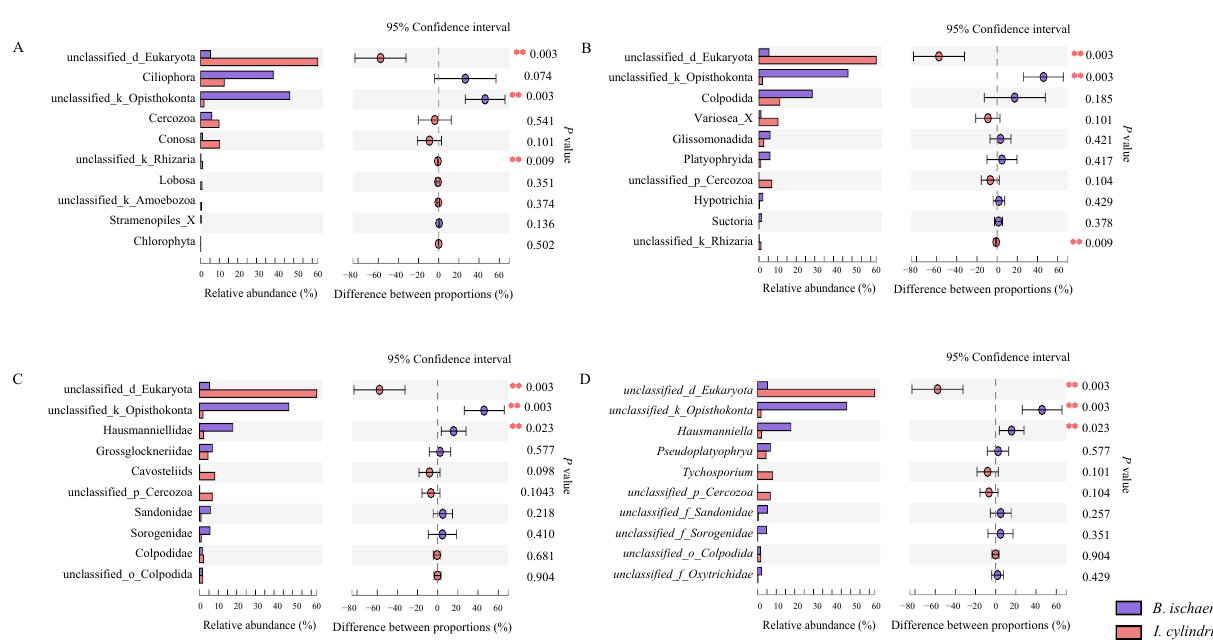
Figure 2. Difference analysis of dominant protist groups among different litters. The top 10 dominant group in relative abundance at the level of phylum ( A ), order ( B ), family ( C ), genus ( D ). LEfSe results showed 31 different protozoan groups in I. cylindrica and B. ischaemum litter at a genus level, which included 9 in B. ischaemum litter and 22 in I. cylindrica litter. In B. ischaemum litter, Hausmanniella (LDA: 4.88) and unclassified_Opisthokonta (LDA: 5.38) were the protozoa detected at a genus level. The main protozoan types found in litter were Tychosporium (LDA: 4.34), Rhogostoma_lineage_X (LDA: 4.34), and unclassified_f_Protostelids (LDA: 4.38) (Figure 3).